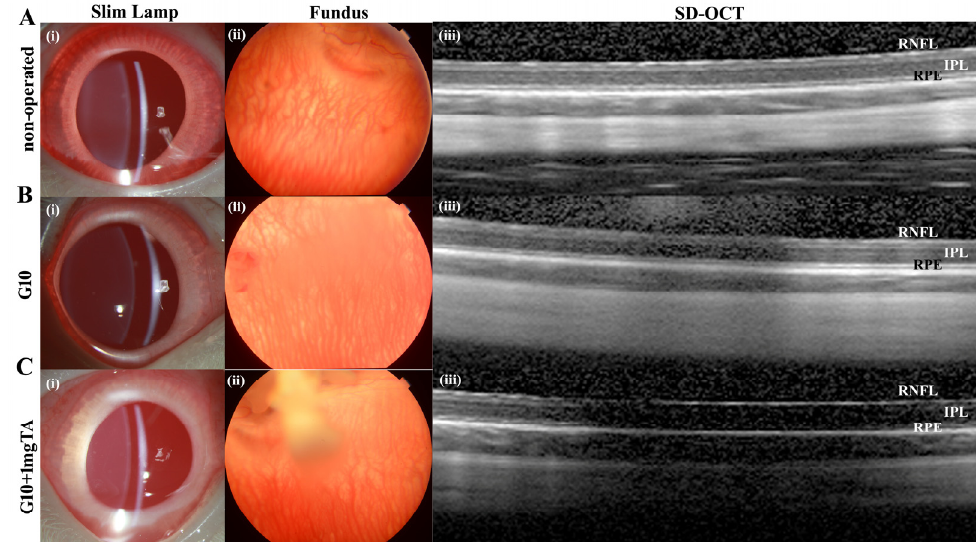
Figure 6. In vivo imaging and ex vivo retinal analysis of rabbits 7 d after implantation of GelMA hydrogels. ( A – C ), Column ( i ): slit-lamp images of operated BSS controls and G10- and G10 + 1 mg TA-injected eyes, showing no significant inflammation or cataract formation. Column ( ii ): images of the fundus showing normal appearance of the optic disc and normal vessel morphology in all groups. Column ( iii ): SD-OCT images obtained in all four groups revealed no reduction in retinal thickness from the RPE to the RNFL.